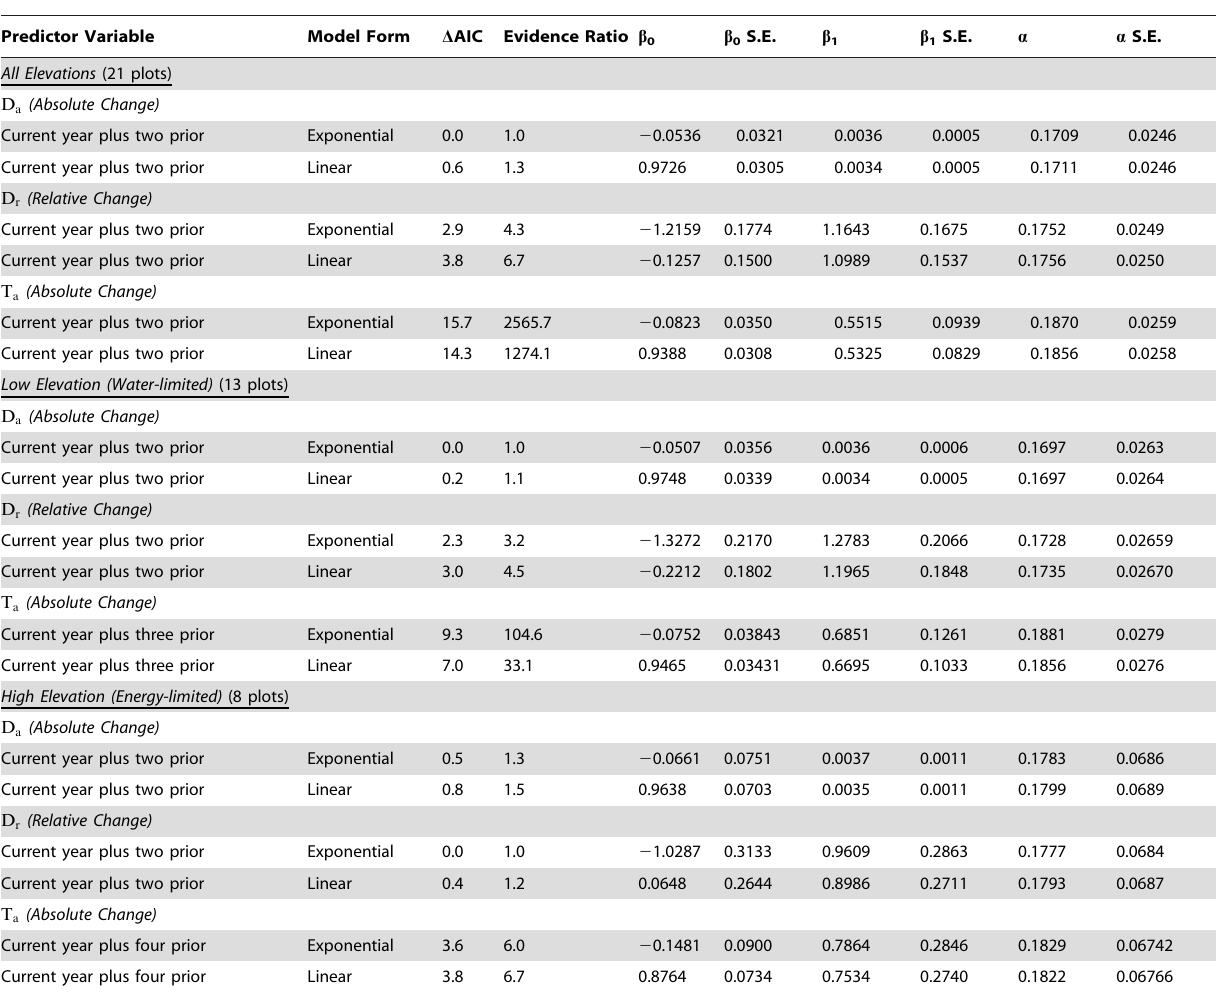
Table 1. Top Ranked Models and